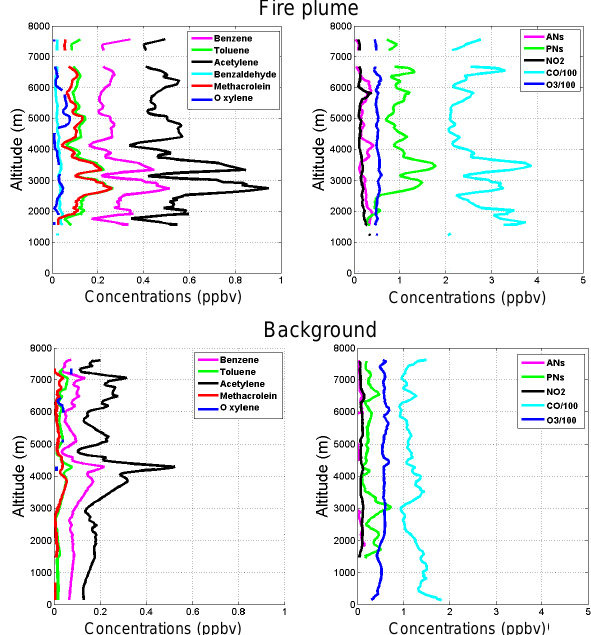
Figure 3. Vertical profiles of benzene, toluene, acetylene, methacrolein, and o-xylene (panels on the left), and P AN, P PN, NO 2 , CO, and O 3 (panels on the right) concentrations averaged for the plume flights (upper panels: B622, B623, B624 flights) and the background flights (lower panels: B619, B622, B630